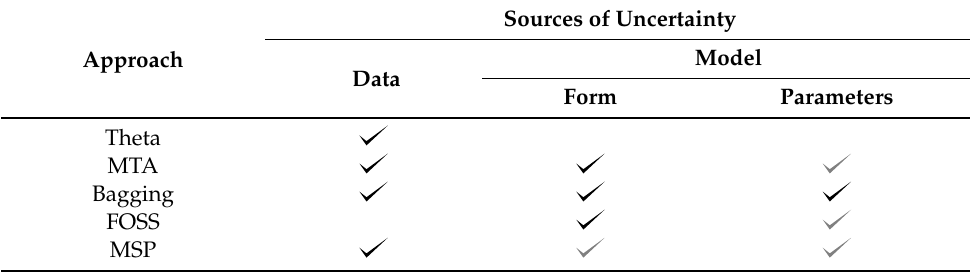
Table 2. How do the five approaches handle the sources of